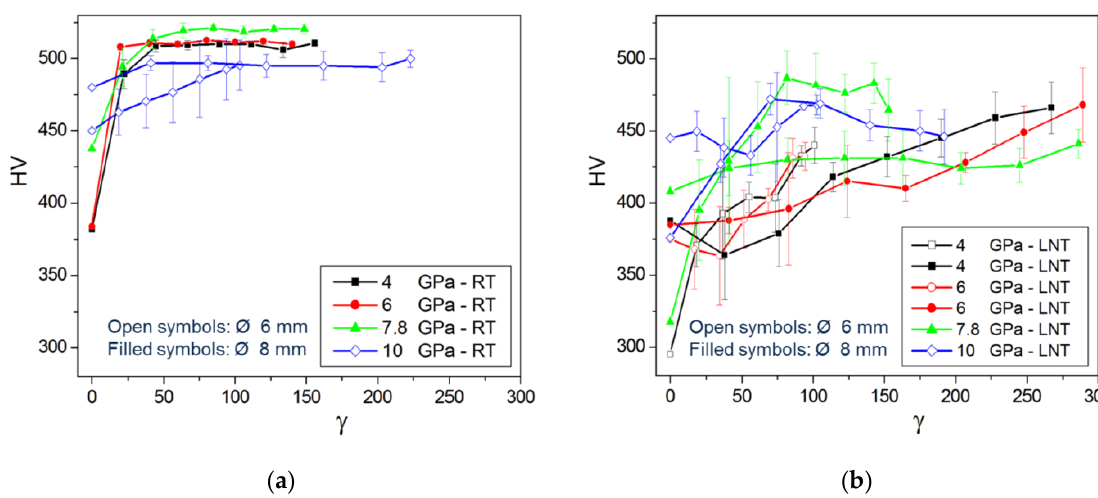
Figure 14. Microhardness measured at RT of samples HPT-deformed at RT ( a ) and LNT ( b ) versus shear strain γ .